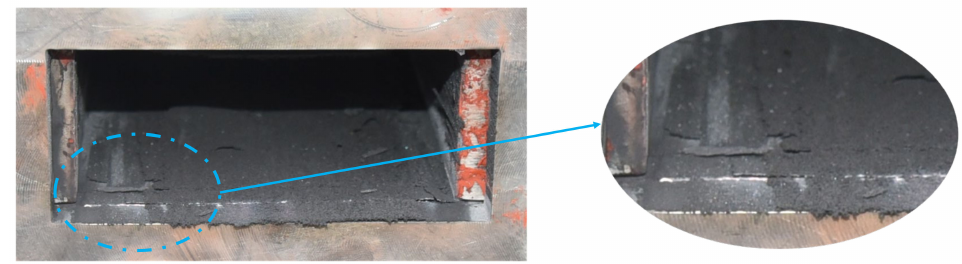
Figure 18. Inner wall surface at the outlet of the combustor after the